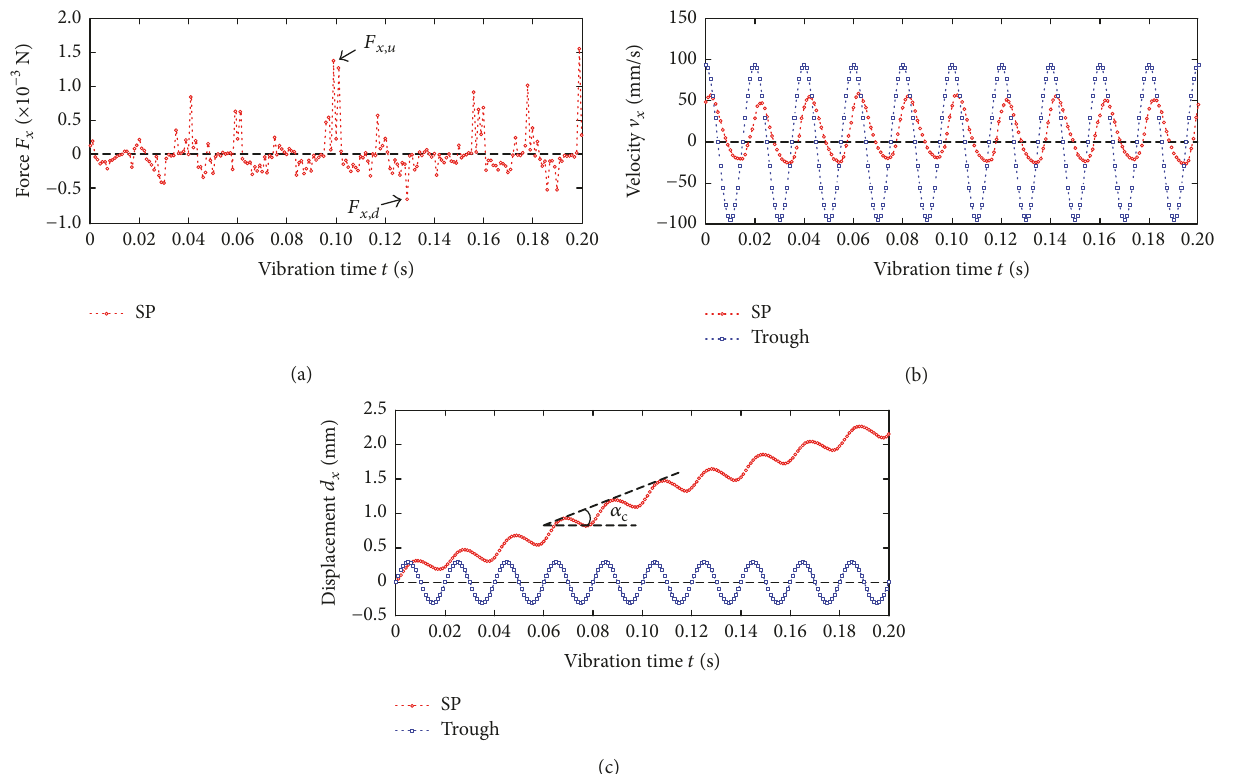
Figure 12: (a) Relationship between the force component of the SP along the 𝑥 -direction and the vibration time. Average velocity components (b) and displacement components (c) of SP and the trough along the 𝑥